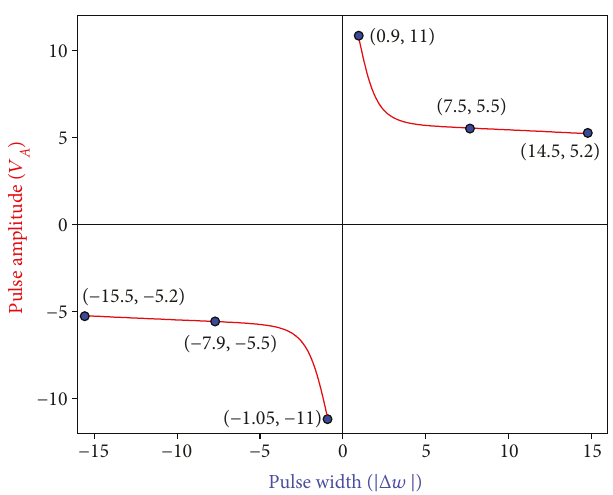
Figure 16: Relation between amplitude V